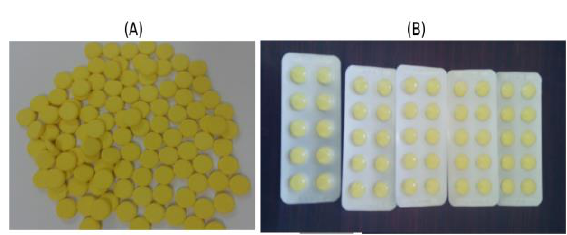
Figure 5: Metronidazole tablets before (A) and after